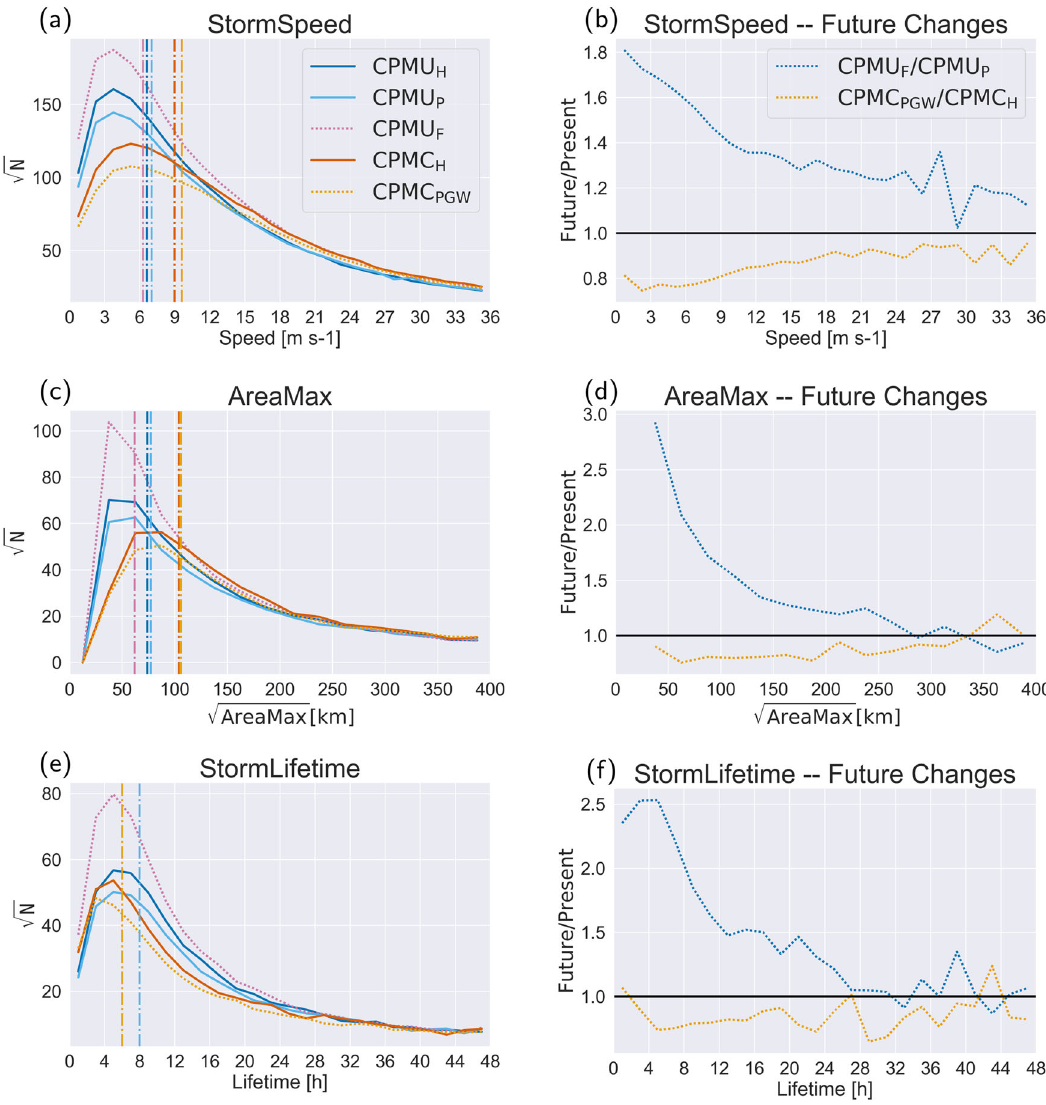
Fig. 4 Histograms of various storm properties and their future changes (continued). Similar to Fig. 3, but for a , b movement speed (StormSpeed), c , d maximum area (AreaMax), and e , f lifetime (StormLifetime). Vertical lines are used to indicate the median. All panels except a and b are diagnosed per MCS track. Storm speed in a and b is diagnosed hourly for each